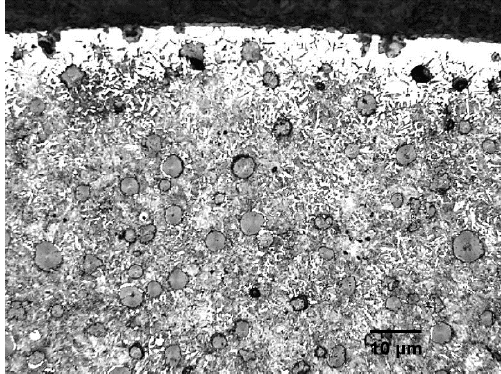
Figure 9. Microstructure of surface decarburization of ductile iron treated at 900 °C.